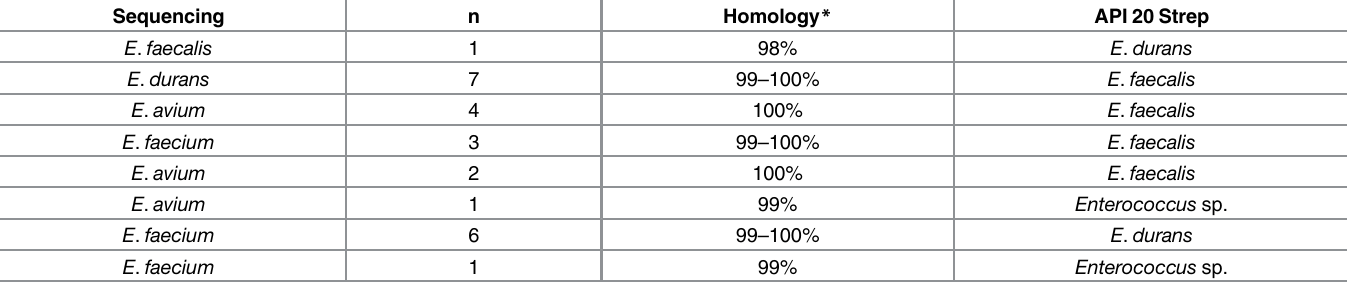
Table 3. Phenotypic (API 20 Strep method) and genotypic (16s rDNA) analytical data of 25 oral enterococcal isolates indicating the divergent nature of the results.